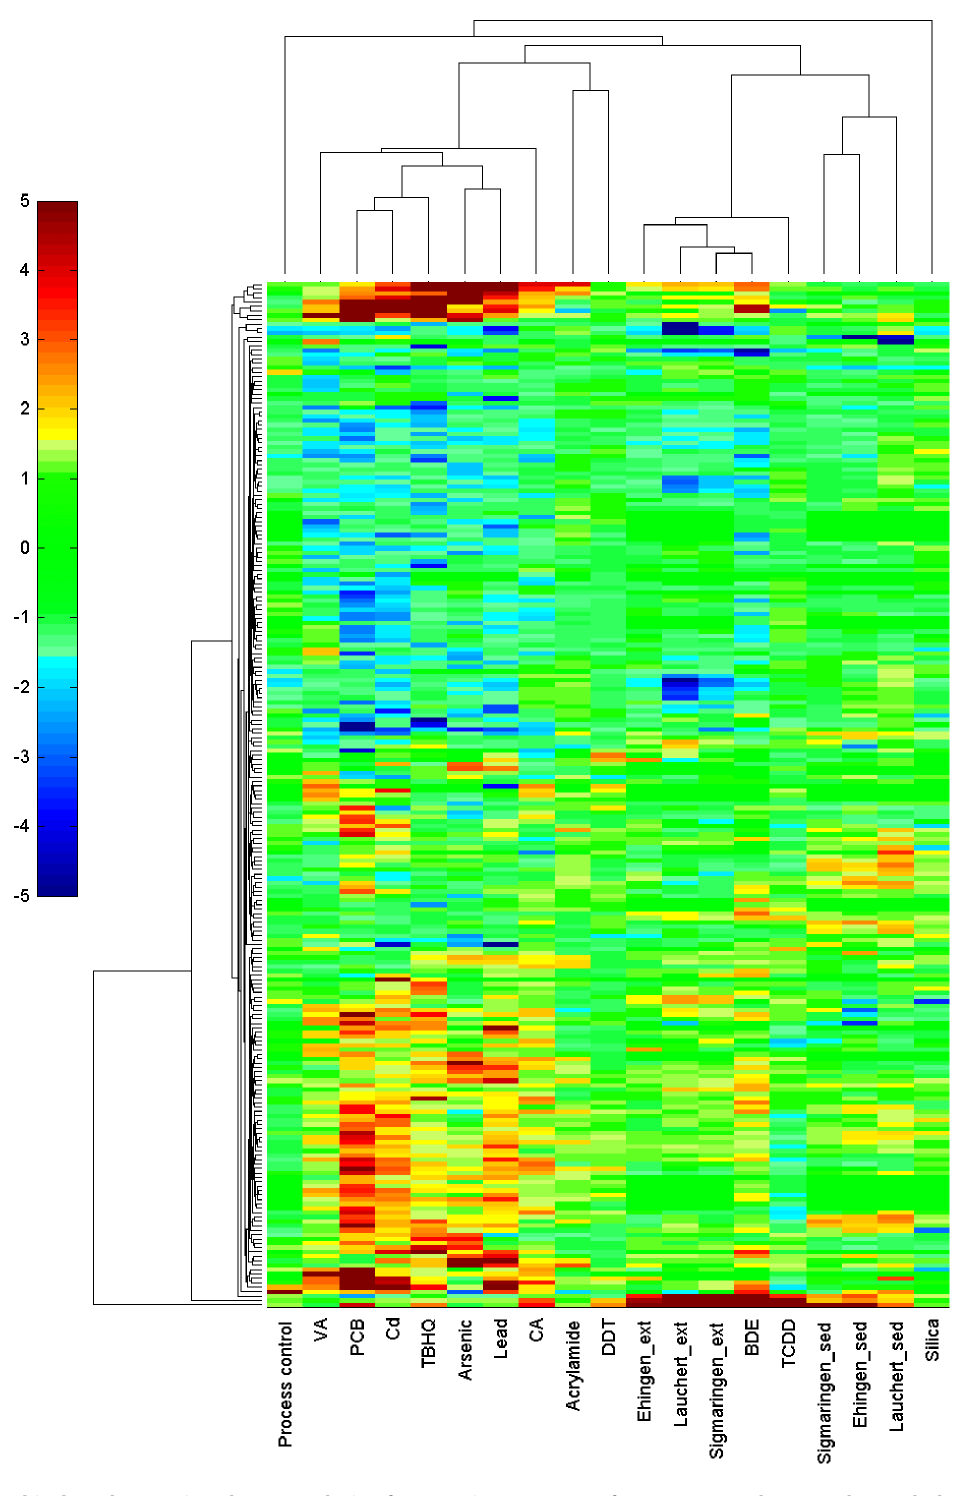
Figure 3. Hierarchical agglomerative cluster analysis of expression patterns of Daniorerio embryos tothree whole sediments and sediment extracts and 11 substances. (Yang et al. 2007; Acrylamide: 71 mg/l; Arsenic: arsenic (III) oxide, 79 mg/l; BDE: 2,2 9 4,4 9 -tetrabromo- diphenyl ether solution 47, 38.9 mg/l; CA: 4-chloroaniline, 50 mg/l; Cd: cadmium chloride, 5 mg/l; DDT: 1,1-bis-(4-chlorphenyl)-2,2,2-trichlorethane 15 mg/l; Lead: lead (II) chloride, 2.8 mg/l; PCB: Aroclor 1254, 33 mg/l; TBHQ: tert-butylhydroquinone, 1.7 mg/l; TCDD: 2,3,7,8-tetrachlorodibenzo- p - dioxin, 500 ng/l; VA: valproic acid, 50 mg/l). The cells are coloured according to the fold-change of a gene under a certain treatment. Blue segments represent genes with a strong decrease in the abundance of the corresponding transcript, red segments represent genes with a strong increase in the abundance of the corresponding transcript and green segments denote unaffected genes.